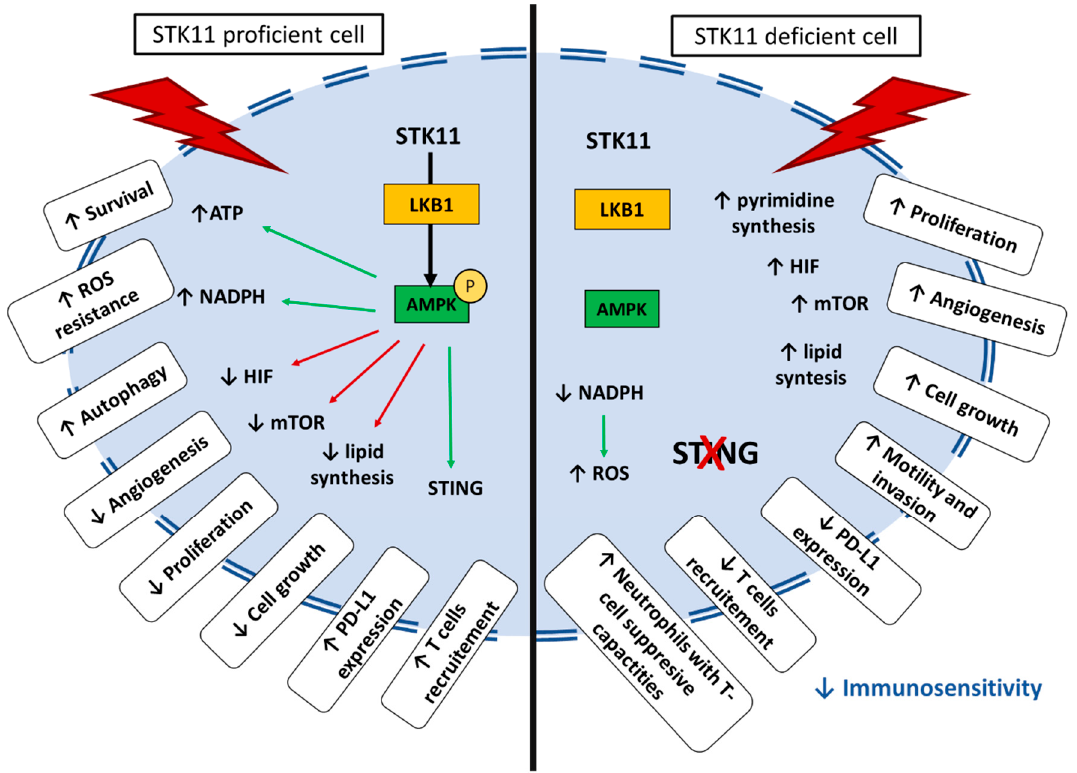
Figure 5. Schematic representation of impact of STK11 -proficient or deficient cell under stress condition.